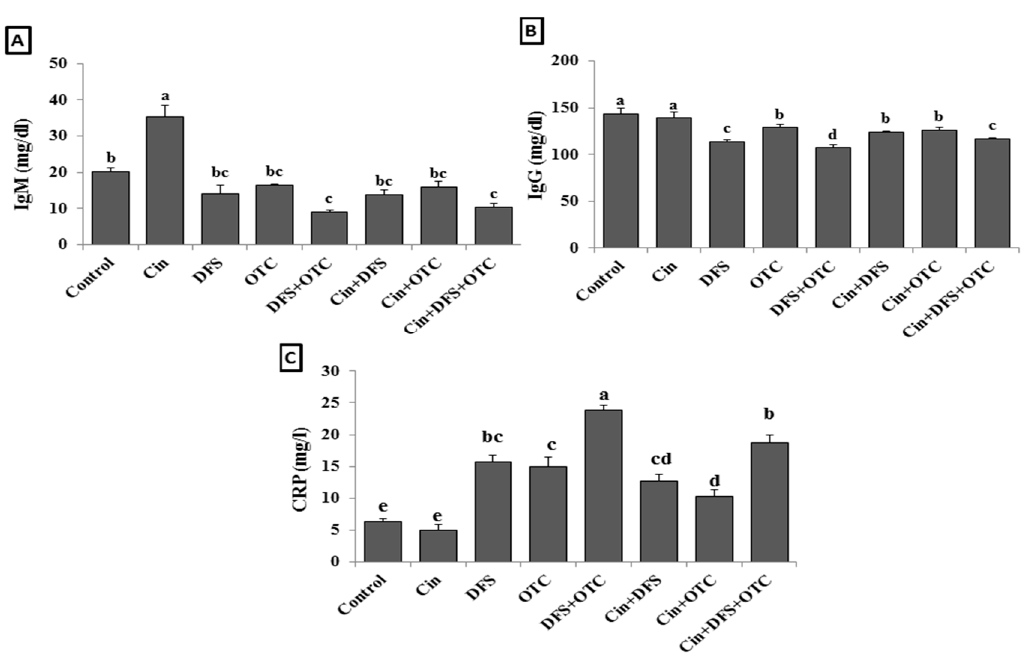
Figure 2. IgM ( A ), IgG ( B ), and CRP ( C ) levels of male albino rats treated orally with cinnamon aqueous extract (Cin, 300 mg/kg b.w./day), single dose of diclofenic sodium (DFS, 100 mg/kg b.w.) and oxytetracycline (OTC, 200 mg/kg b.w./day). Data are expressed as the mean ± SEM (n = 8). Each bar carrying different letters (a, b, c, d, e) is significantly different ( p < 0.05).